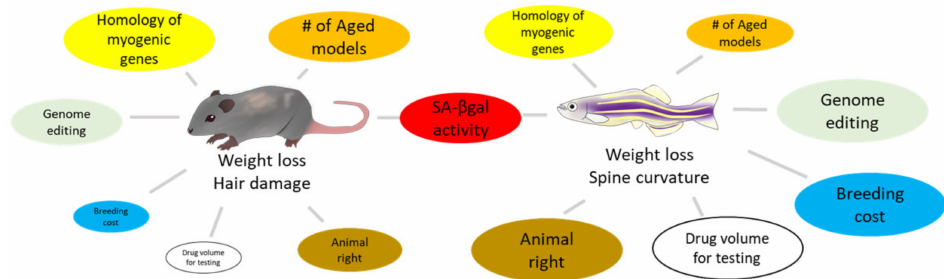
Figure 2. Comparison between rodents and zebrafish for skeletal muscle senescence. The size of each circle visualizes its advantage as a model